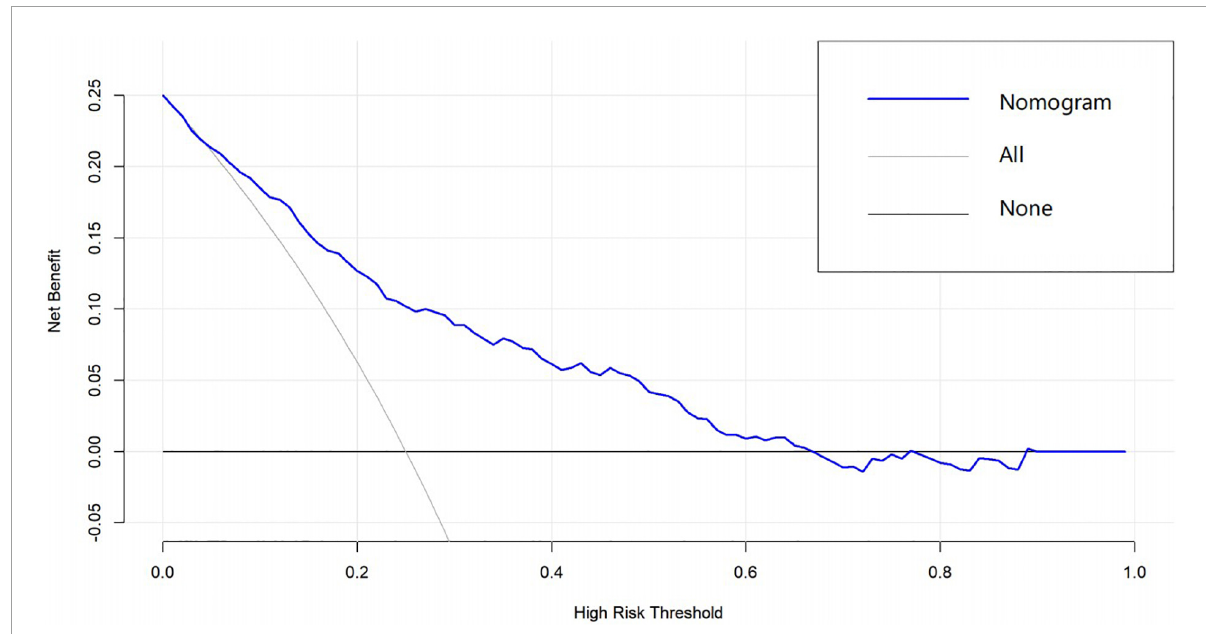
FIGURE6 Decision curve analysis of the predictive nomogram. The x-axis and the y-axis represent the net benefit and high-risk threshold, respectively.